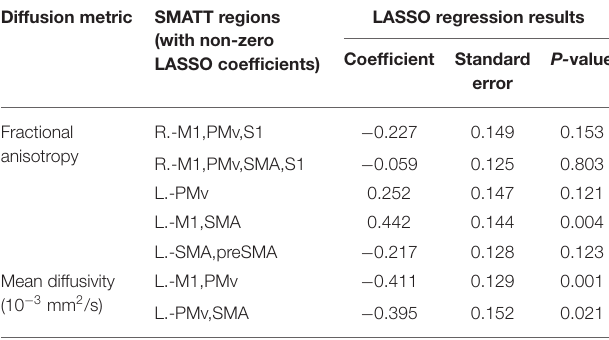
TABLE 2 | SMATT regions whose fractional anisotropy or mean diffusivity were LASSO regression predictors of Fugl-Meyer upper extremity scale. Diffusion metric SMATT regions (with